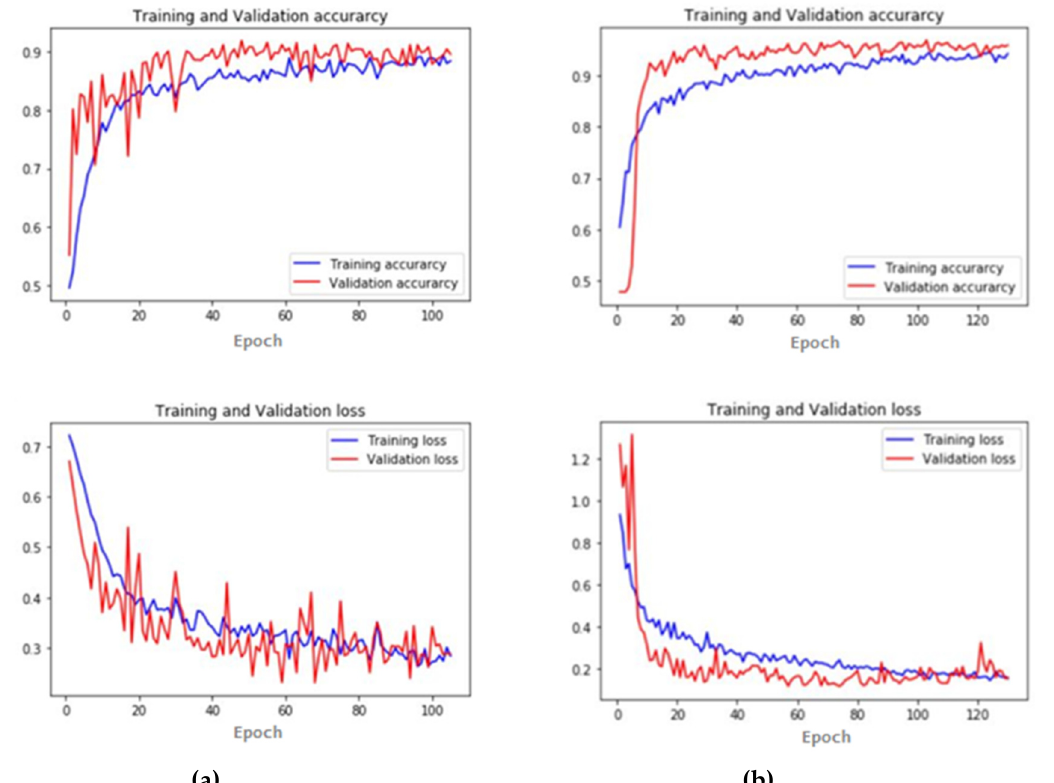
Figure 7. Accuracy and loss profiles of training and validation in the two models. ( a ) VGG-19 model; ( b ) ResNet-50 model. Table 4. The testing results for the VGG-19 and ResNet-50 models. TP, TN, FP, and FN denote the true positive, true negative, false positive and false negative pulses,